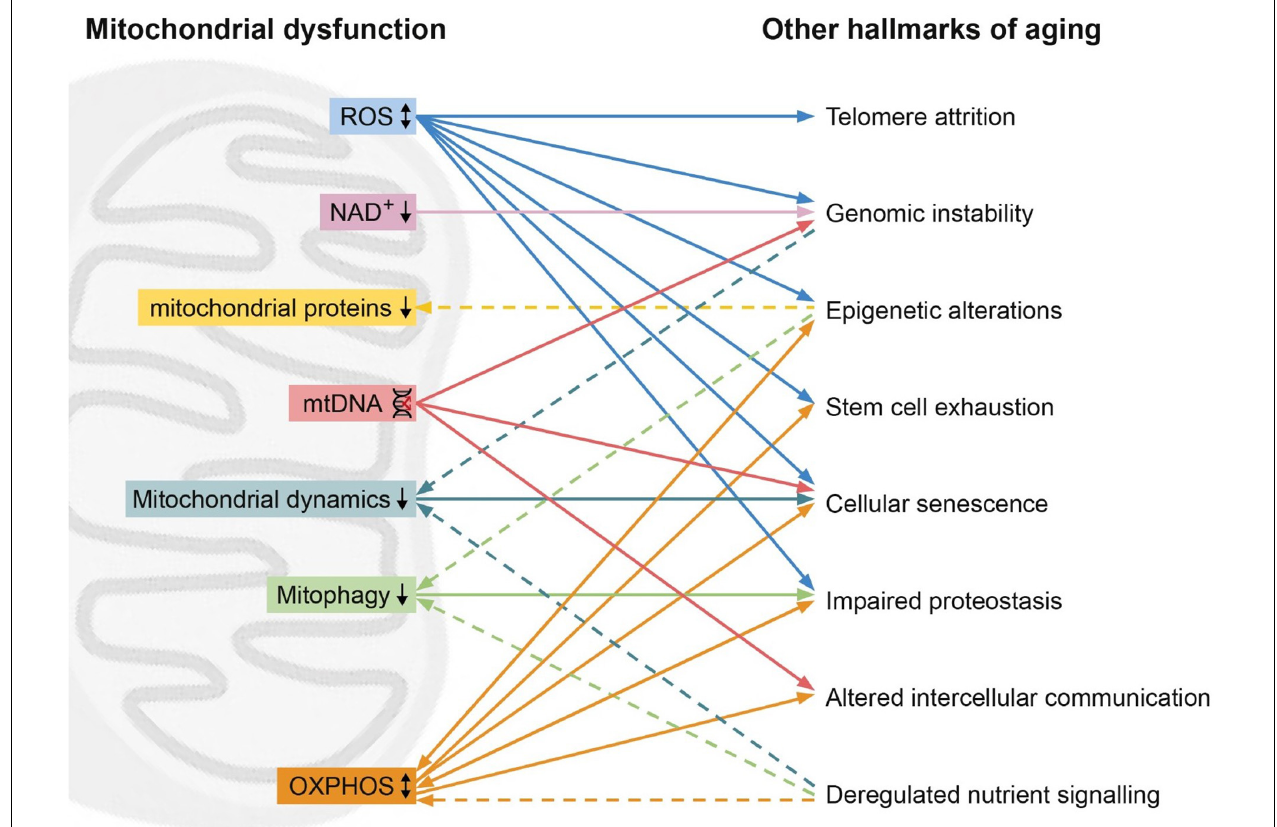
FIGURE 1 | Mitochondrial dysfunction (left) and its relation with other hallmarks (right). High levels of reactive oxygen species (ROS, blue) can lead to telomere attrition, genomic instability, epigenetic alternations, stem cell exhaustion, cellular senescence. On the other hand, ROS can also improve proteostasis. Low levels of NAD + (pink) can lead to genomic instability. Epigenetic alterations can lead to reduced mitochondrial proteins (yellow) such as STEAP2, RHOT2, and RAB32. Mitochondrial DNA (mtDNA) damage (red) can result in genomic instability, cellular senescence and altered intercellular communication. Hallmarks of aging genomic instability and deregulated nutrient sensing can lead to reduced mitochondrial dynamics (turquoise), while reduced mitochondrial dynamics induces cellular senescence. Reduced mitophagy (green) leads to impaired proteostasis, while epigenetic alterations and deregulated nutrient sensing induce reduced mitophagy. Oxidative phosphorylation (OXPHOS, orange) affects the hallmarks epigenetic alterations, stem cell exhaustion, cellular senescence, impaired proteostasis, altered intercellular communication and is in turn affected by deregulated nutrient sensing, epigenetic alterations and impaired proteostasis. Dashed line represents an effect of a hallmarks of aging on the mitochondrial